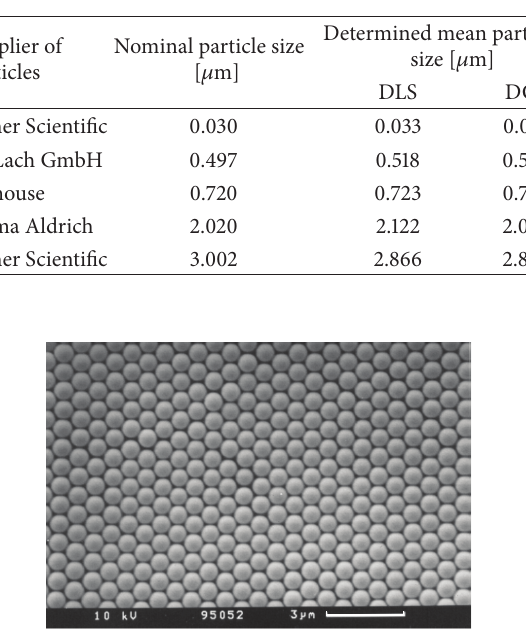
Table 1: Comparison of the nominal and determined particle size (diameter) of the polystyrene latex suspensions.